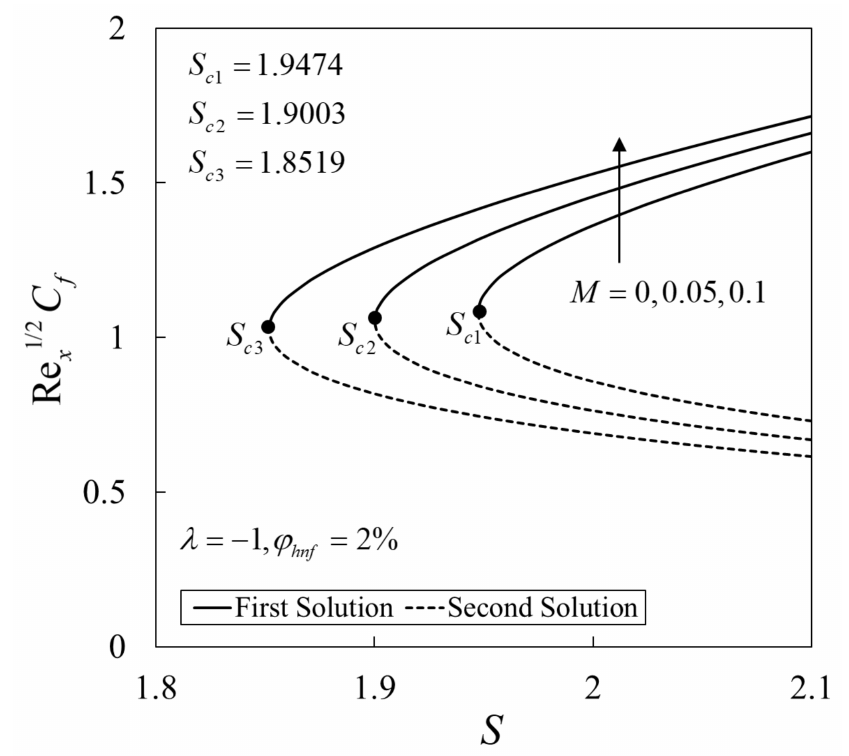
Figure 6. Variations of the local Nusselt number Re 1/2 x C f against suction parameter S for different values of M .